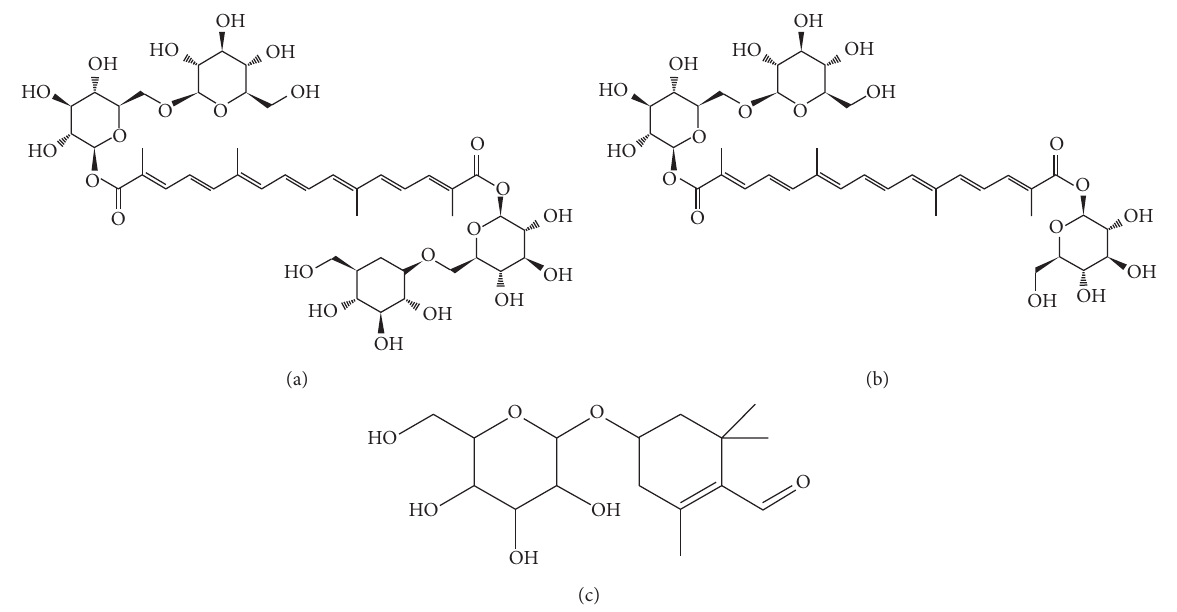
Figure 9: The chemical structure of crocin I (a), crocin II (b), and picrocrocin